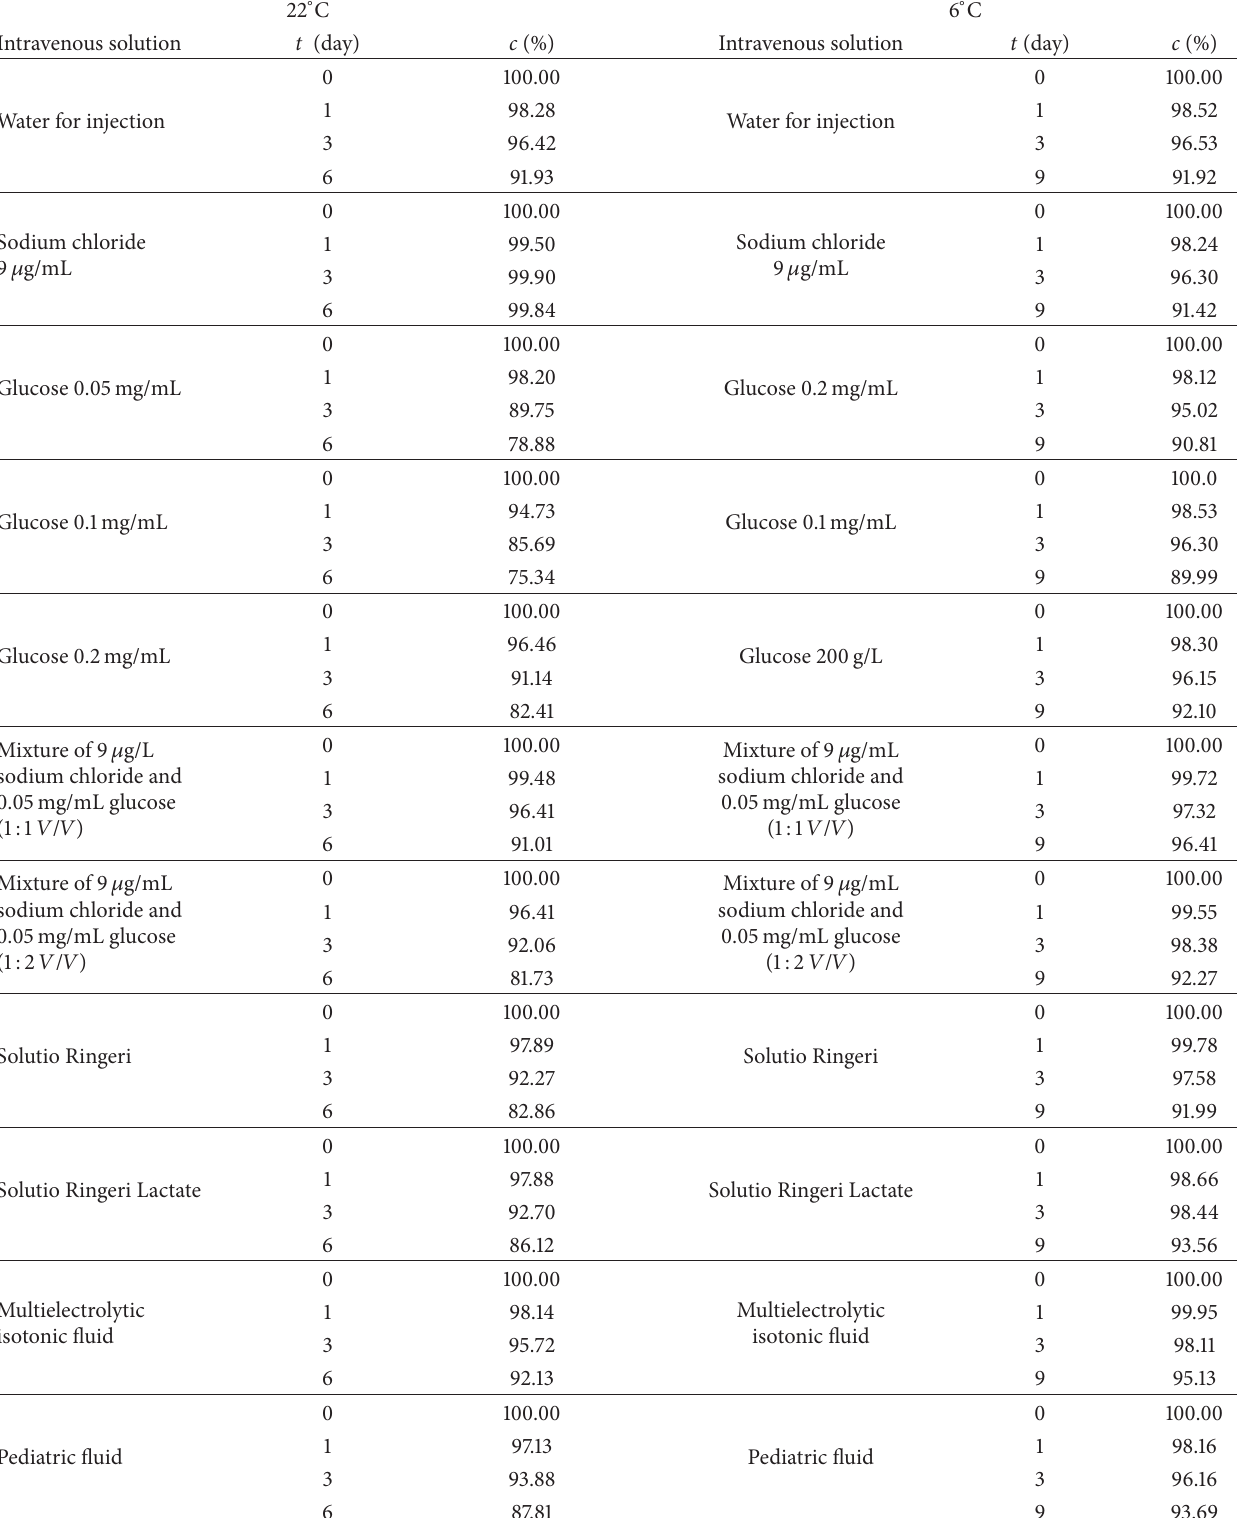
Table 2: Stability of cefquinome sulphate stored in poly(vinyl chloride)